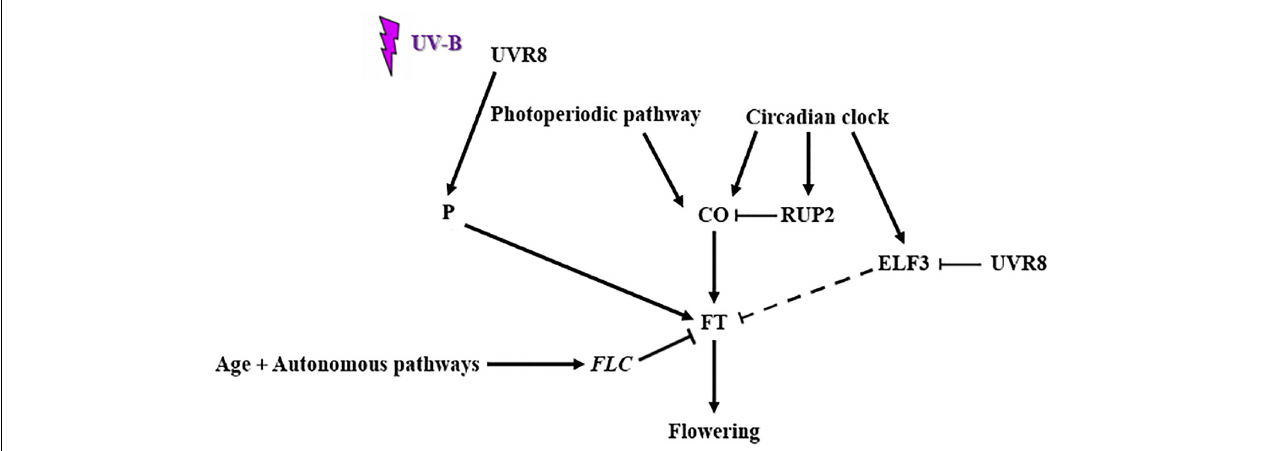
FIGURE 5 | Schematic representation of UV-B mediated control of flowering time (factors and flowering pathways involved). Upon UV-B irradiation multiple flowering pathways control flowering time. The age and autonomous pathways lead to an upregulation of FLC [as demonstrated by Dotto et al. (2018)], which acts as an FT repressor. CO and FT are flowering promoting factors of the photoperiodic pathway. CO is repressed by RUP2, a negative regulator of UVR8 signaling [as demonstrated by Arongaus et al. (2018)] and a circadian clock component. ELF3, another circadian clock component also represses FT , indirectly by targeting CO for degradation. UVR8 represses ELF3 and possibly interacts with another protein factor (P) in order to promote FT gene